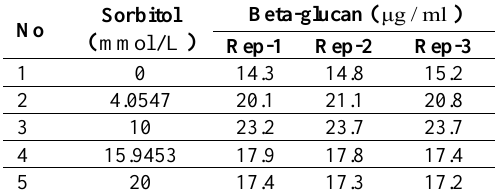
Table 5. Data set for Sorbitol and